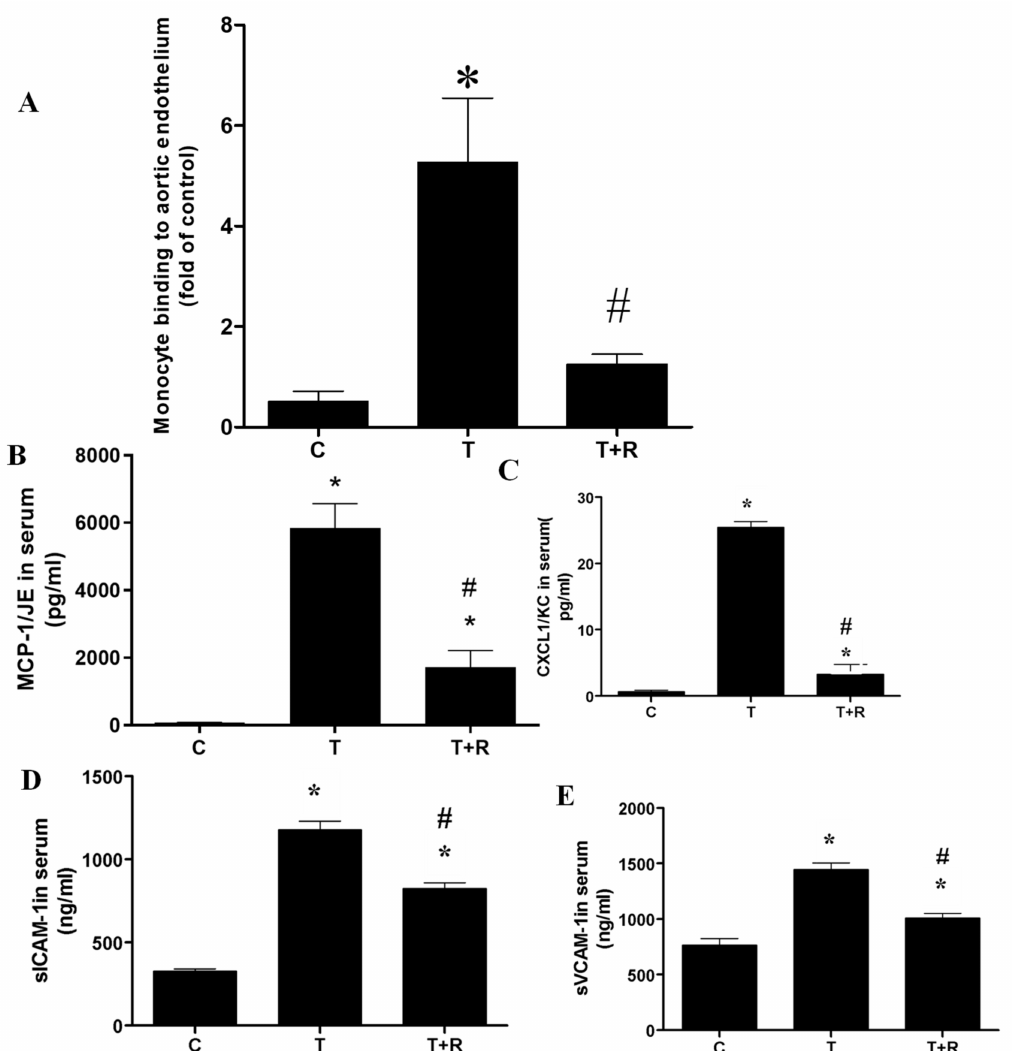
Figure 4. Dietary intake of resveratrol decreased monocyte binding to aortic endothelia ( A ), secretion of chemokines ( B , C ) and adhesion molecules ( D , E ) in the serum of TNF- α -treated mice. MCP-1/JE, CXCL1/KC, sICAM-1, and sVCAM-1 in serum were analyzed using ELISA. Values represent mean ± SEM. *, p < 0.05 vs. control; #, p < 0.05 vs. TNF- α -alone- treated mice. T, tumor necrosis factor- α ; MCP-1/JE, mouse monocyte chemotactic protein 1/JE; CXCL1/KC, chemokine (C-X-C motif) ligand 1; sICAM-1, soluble intercellular adhesion molecule-1; sVCAM-1, soluble vascular adhesion